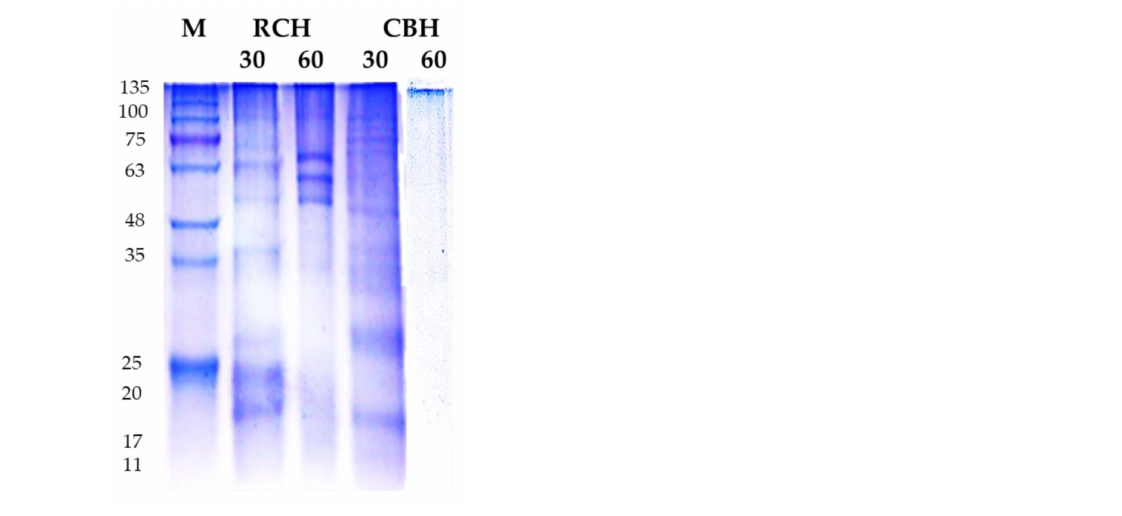
Figure 1. SDS electropherogram (18%) of RCH and CBH isolated from cluster and red kidney bean seeds wastes. Lane 1, M, molecular marker (Tris-Glycine SDS-PAGE, 4–20%). Lanes 2 and 4 represented protein bands of protein isolates after 30 min pepsin hydrolysis; lanes 3 and 5, represented 60-min pepsin hydrolysis at 37 ◦ C of protein isolates. Buffer system, discontinuous SDS-PAGE buffer system (Tris HCl, pH 6.8 for staking gel, and Tris HCl, pH 8.8 for resolving gel). 5 µ L of protein in loading sample buffer was loaded in each well.